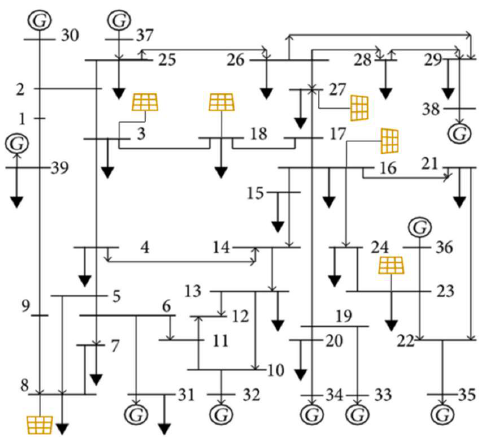
Figure 7. Modified IEEE 39 bus system diagram.